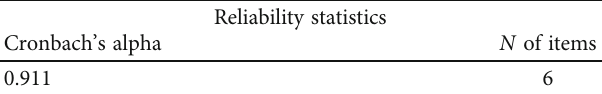
Table 11: Cronbach ’ s alpha for motivation.